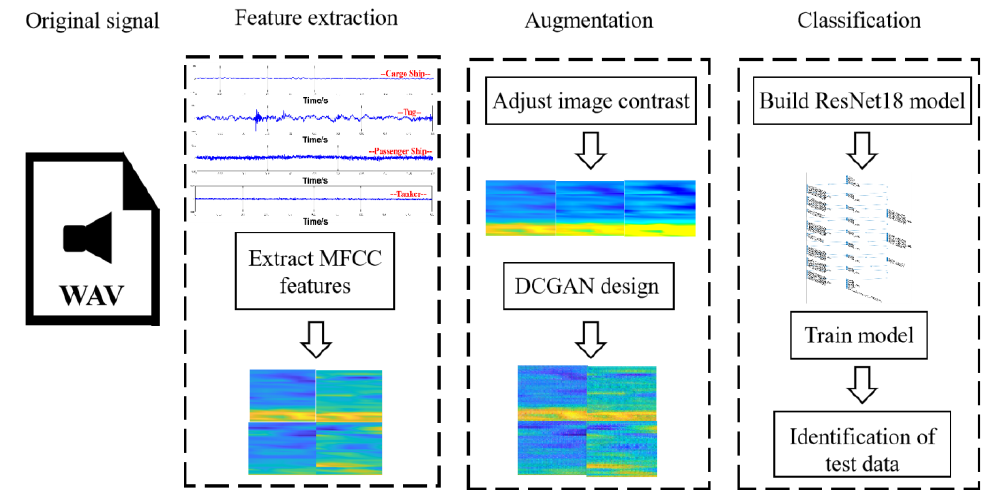
Figure 1. Overall flow diagram.